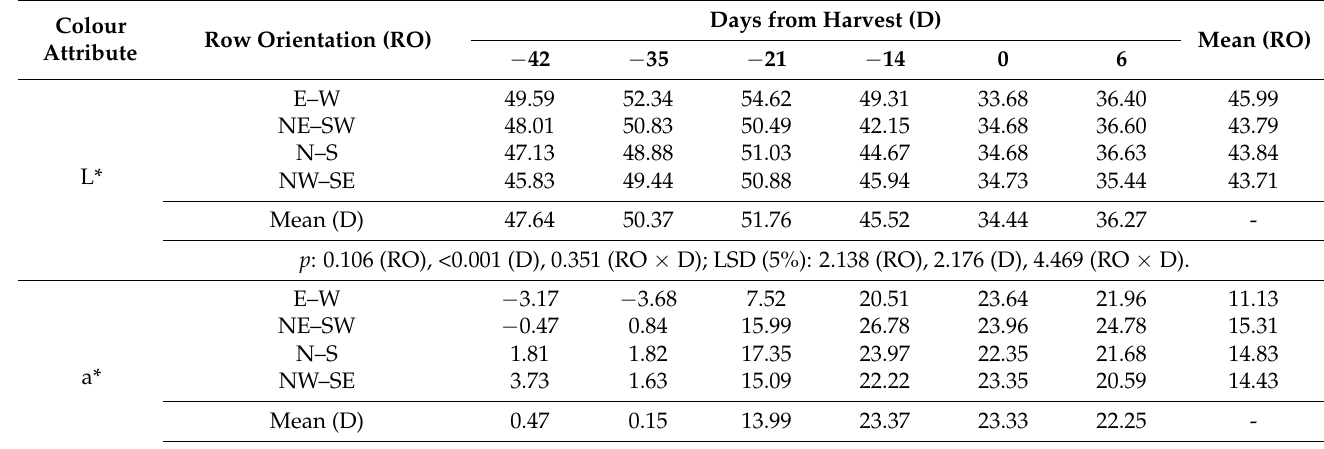
Table 4. Skin colour attributes of ‘Majestic Pearl’ nectarines subjected to different row orientations. Means, ANOVAs’ p -values and Fisher Least Significant Differences (LSD, 5%)